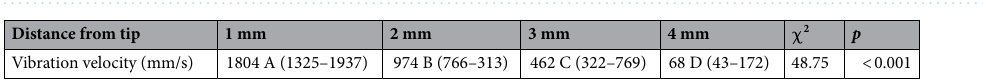
Table 2. Resin vibration at various distances from the resin applicator tip. Interquartile ranges (first quartile, third quartile) are in parentheses. Different uppercase letters indicate statistically significant difference (row) in the Kruskal–Wallis and multiple comparisons by Mann–Whitney U test, p < 0.05). χ 2 , chi-square; p ,